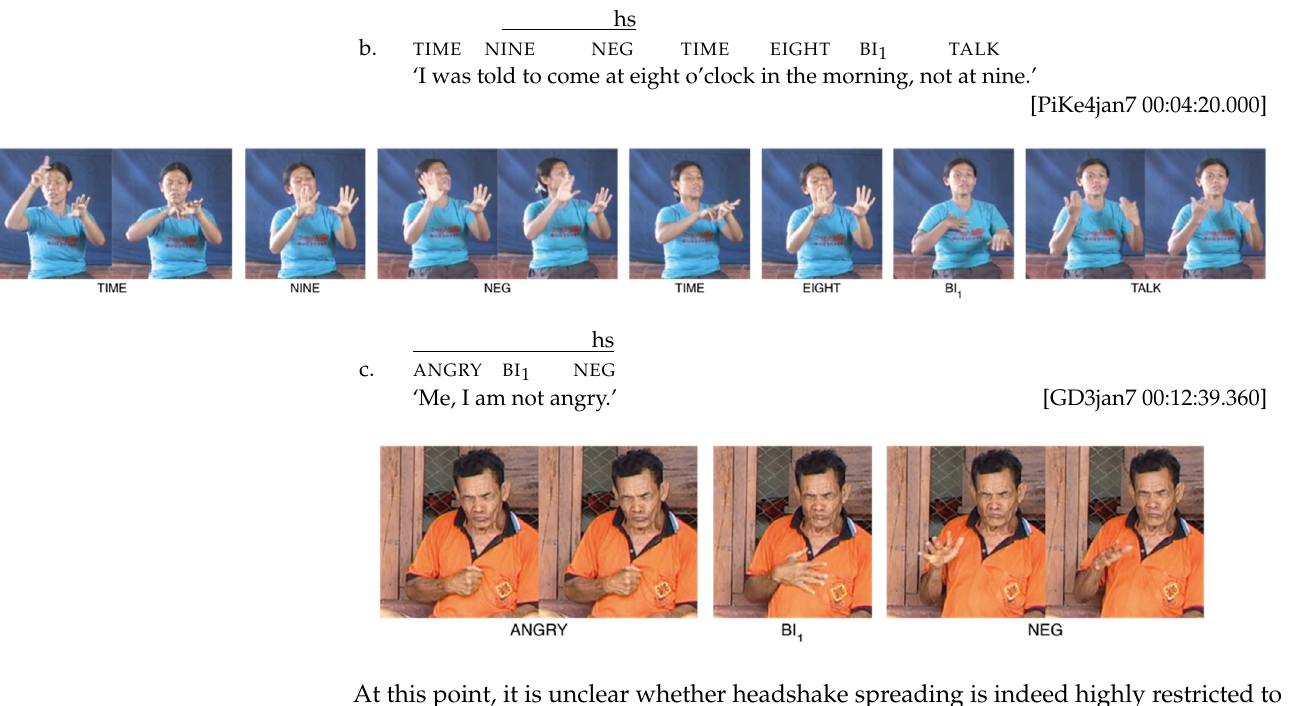
Figure 3. Distribution of headshake spreading across the three generations. 6.2.2. Tongue Protrusion Tongue protrusion is observed in a total of 30/162 instances of negation (18.5%). Four different patterns are attested: tongue protrusion may combine with NEG , as in example (7b), repeated here as (9a) (N = 7); it may be co-articulated with NEG and headshake (N = 18), as shown in (9b); it may be the sole negator (N = 3), illustrated in (9c); and it may be co-articulated with a headshake (N = 2) in the absence of the manual negator